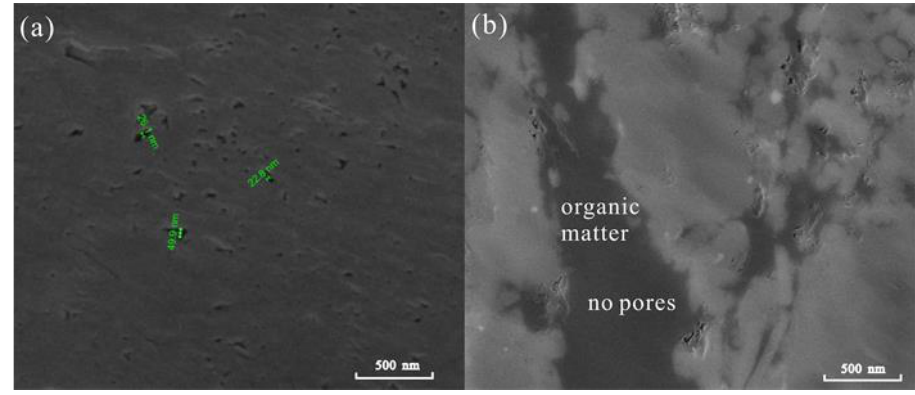
Figure 11. ( a ) Organic pores in sample 5; ( b ) Organic matter in sample 59.